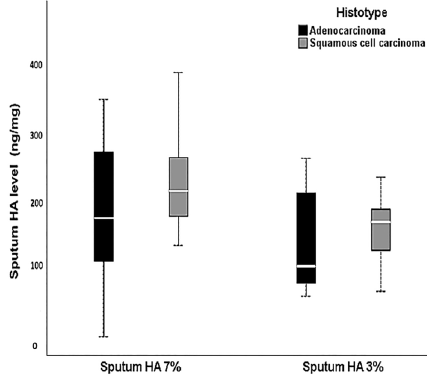
Figure 1. Plots demonstrate the differences between sputum hyaluronan (HA) levels collected with 7% NaCl or with 3% NaCl at the time of diagnosis, strati fi ed by adenocarcinoma and squa- mous cell carcinoma histotypes. Solid bars represent HA levels in ng/mg between the 25th and 75th percentiles, the white bar shows the median value, and the top and bottom brackets show the extreme values. The Wilcoxon rank-sum test was used for